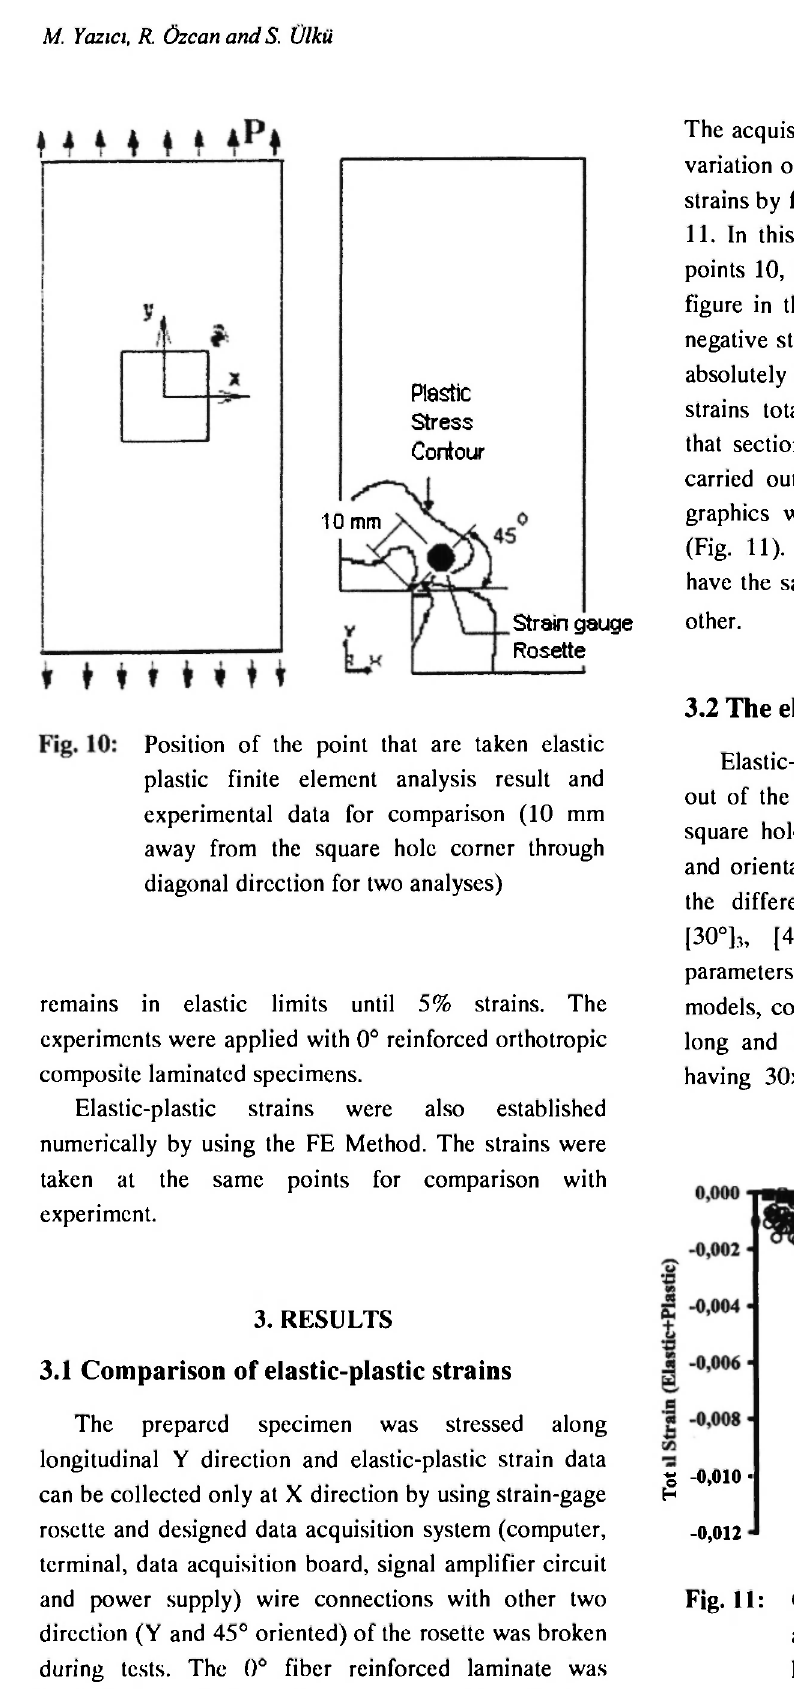
Fig.U: Comparison of X direction Finite Element and Experimental total strain variations by loading step. Data were carried out from illustrated point in